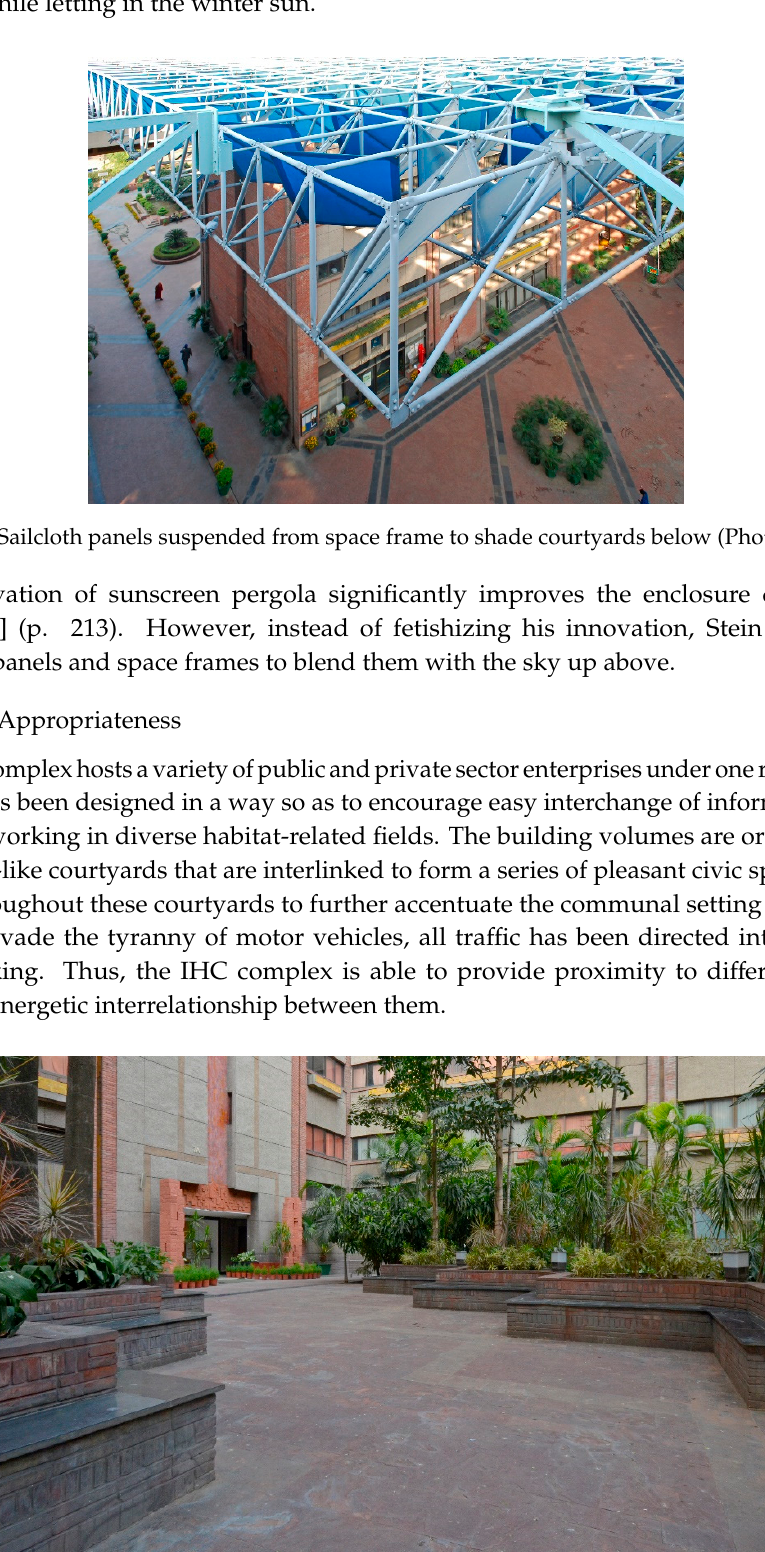
Figure 20. Seatwalls provided in the courtyards of India Habitat Centre (Photo: Author).